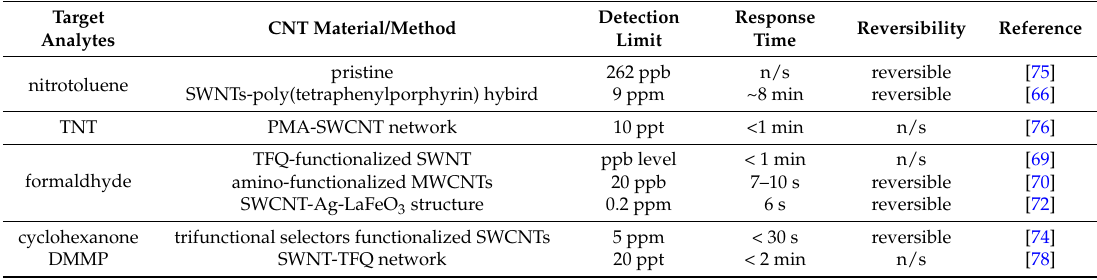
Table 3. Summary of sensing performance of VOCs chemiresisitive